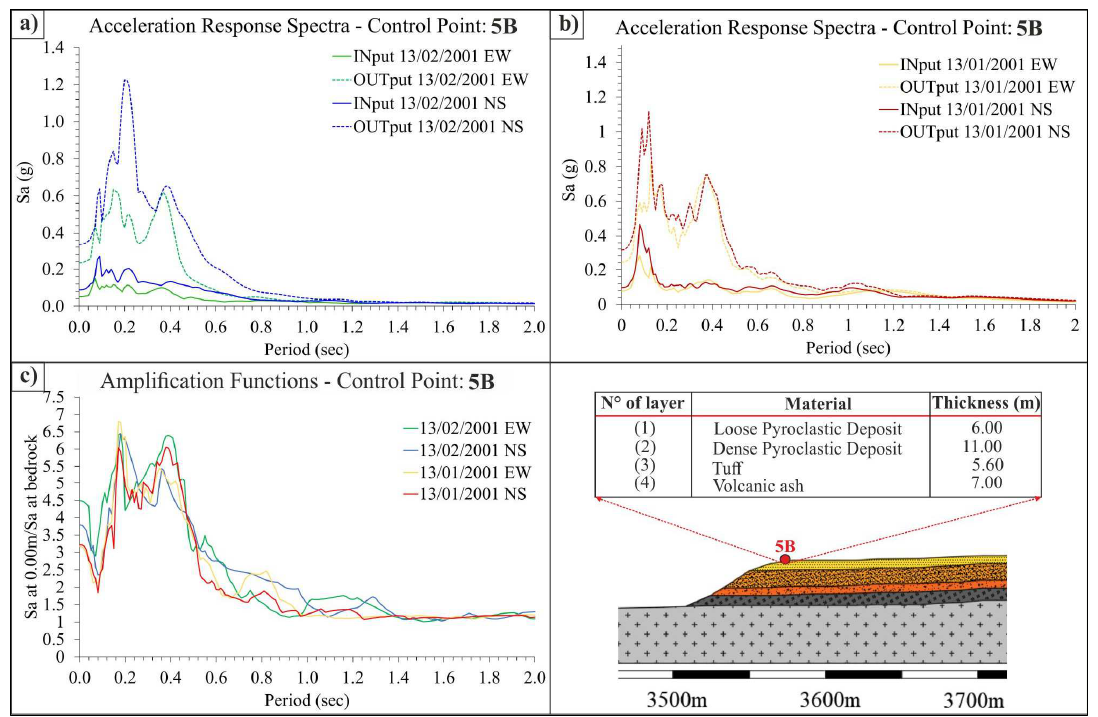
Figure 22. Section BB′: numerical control point 5B spectral responses obtained by 2D numerical analyses using LSR2D software. ( a ) Comparison among the SA of the two components of the 13 February 2001 earthquake. ( b ) Comparison among SA of the two components of the 13 January 2001 earthquake. ( c ) Amplification functions related to the four input